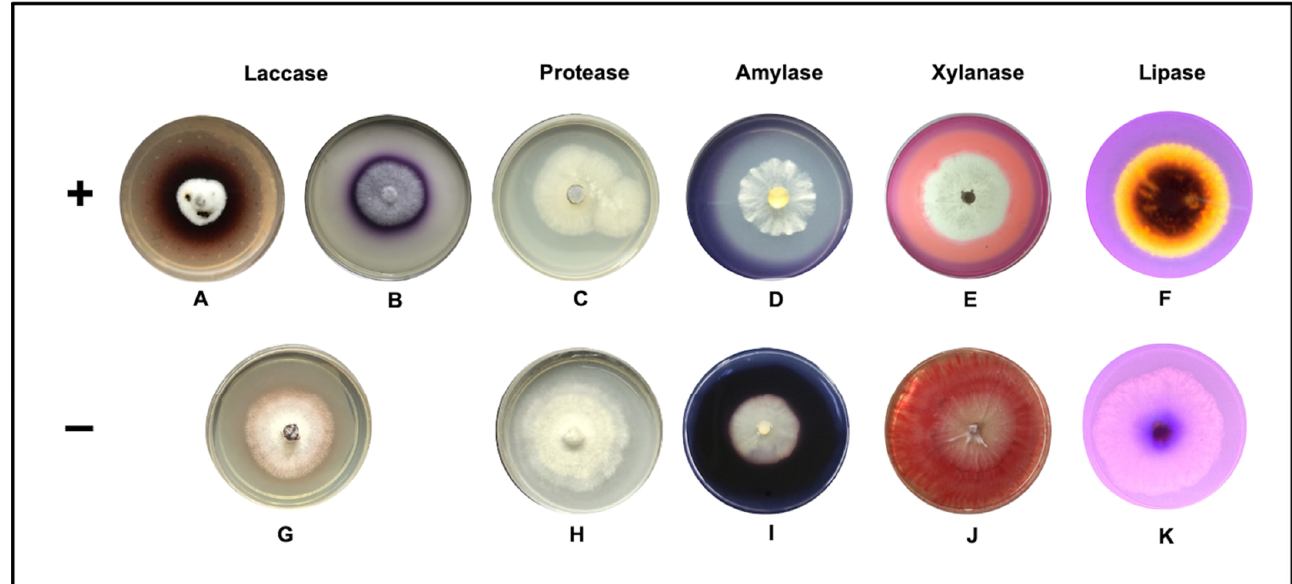
Figure 2. Qualitative enzymatic assay on solid medium with visible enzymatic activity ( A – F ) and without activity ( G – K ).